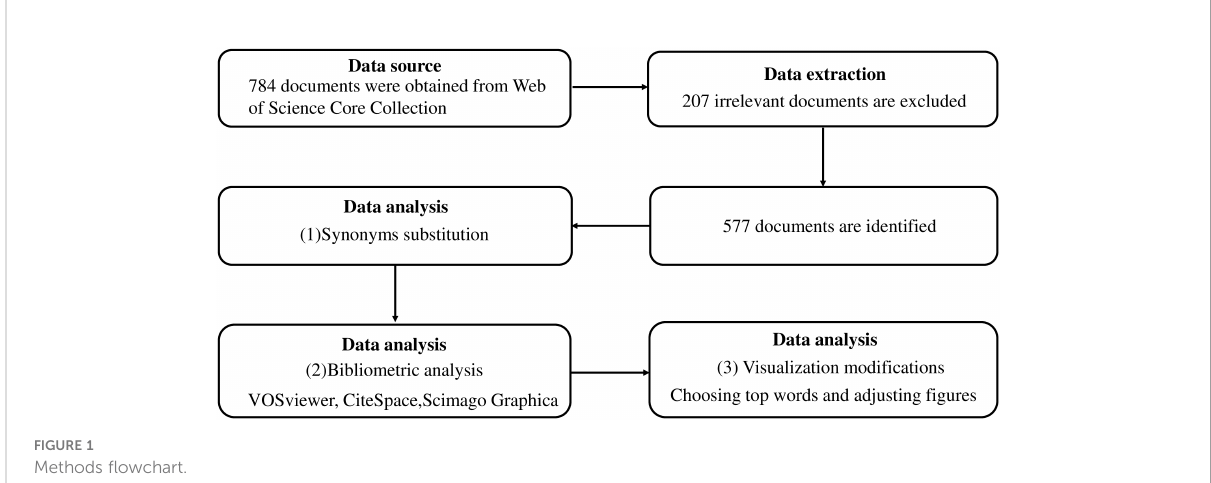
FIGURE 1 Methods fl